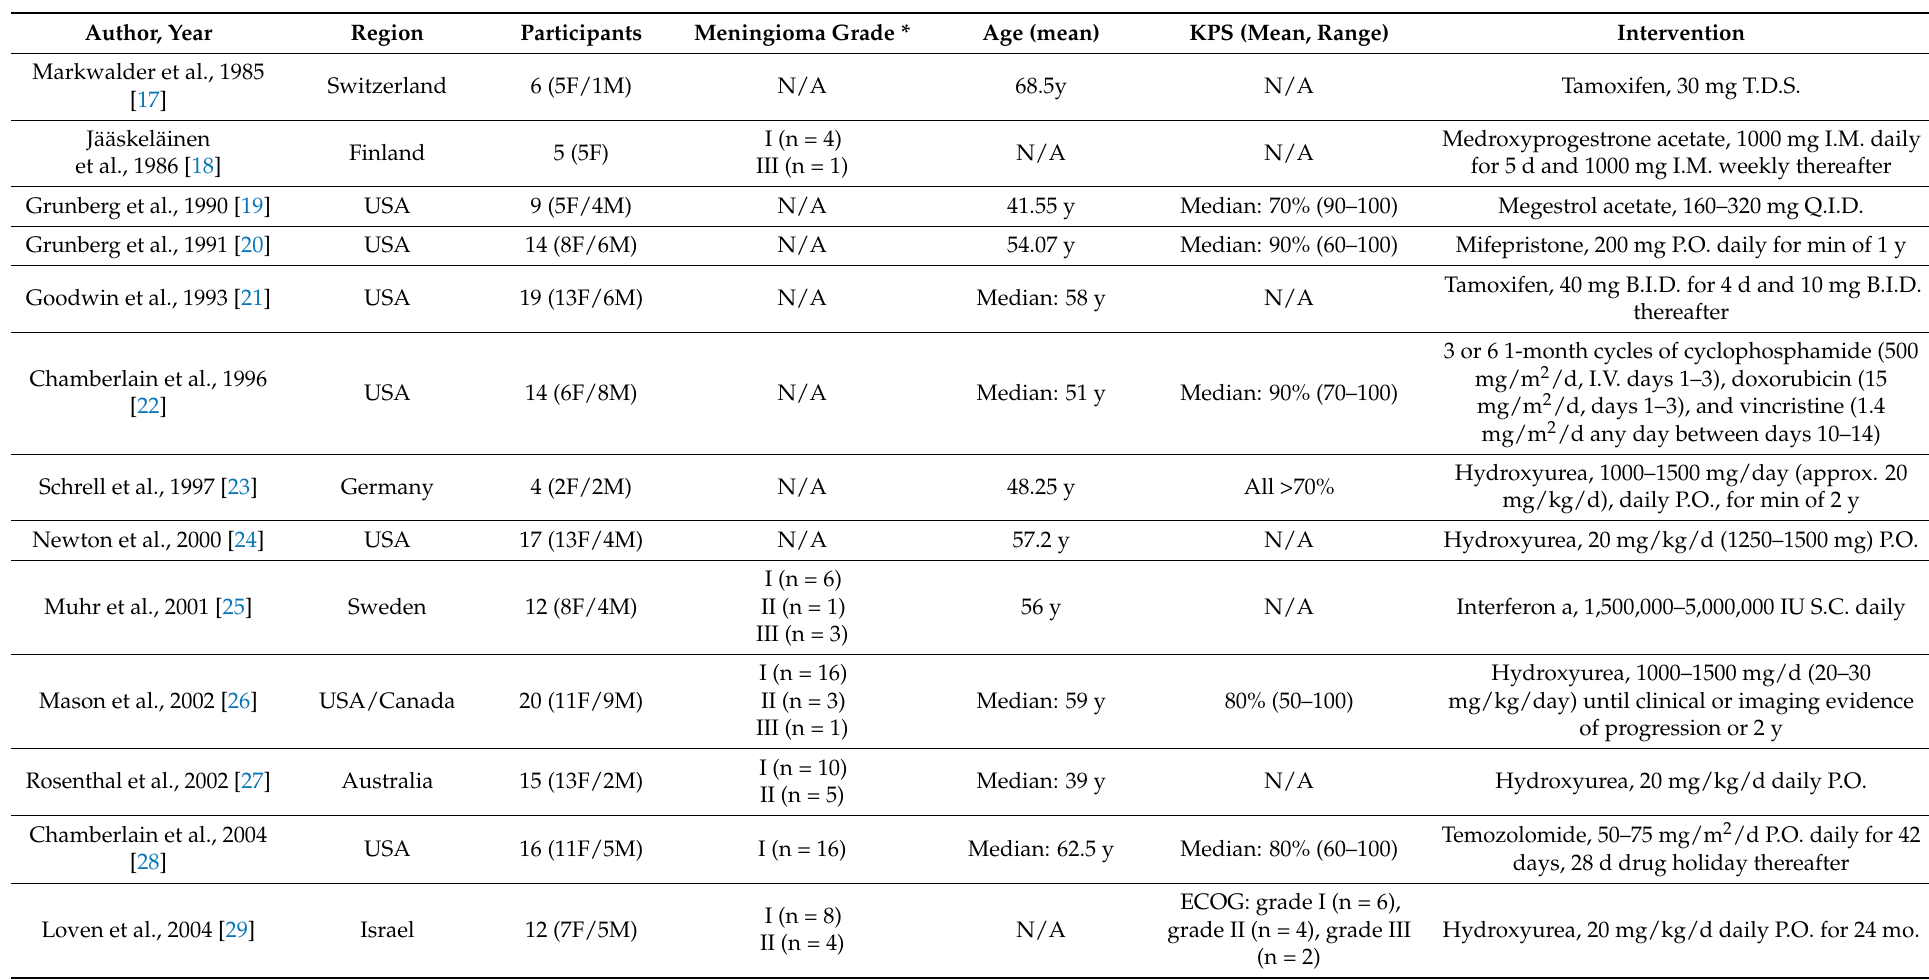
Table 1. Characteristics of the included